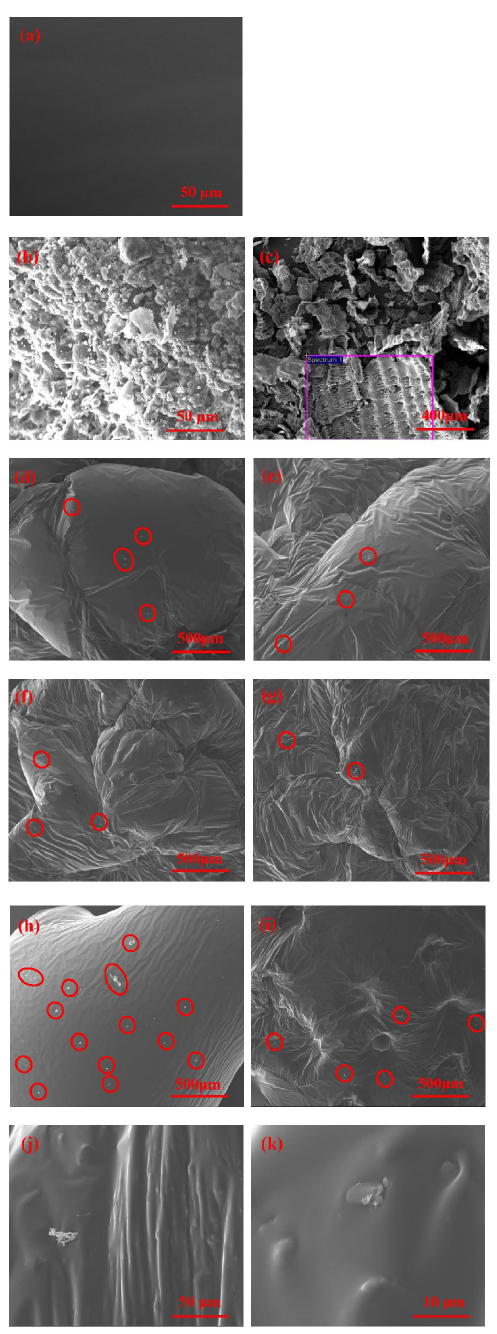
Figure 12. Scanning electron microscopic image of modifier and composite-modified asphalt. ( a ) Base asphalt, ( b ) SBS, ( c ) RHB, ( d ) 7.5% RHB + 4% SBS, ( e ) 10% RHB + 4% SBS, ( f ) 12.5% RHB + 4% SBS, ( g ) 15% RHB + 4% SBS, ( h ) 15% RHB + 2% SBS, ( i ) 15% RHB + 3% SBS, ( j ) Composite-modified asphalt with 800 times magnification, and ( k ) Composite-modified asphalt with 3000 times